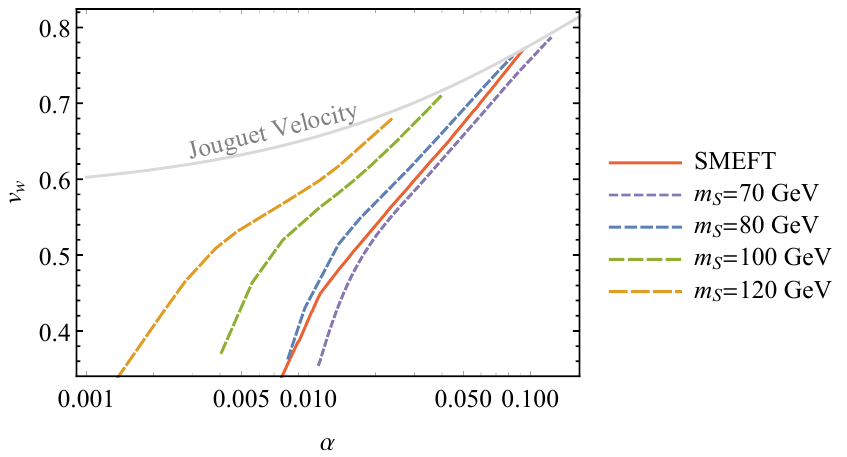
Figure 17 . Bubble wall velocity solutions as a function of the phase transition strength α for all the models